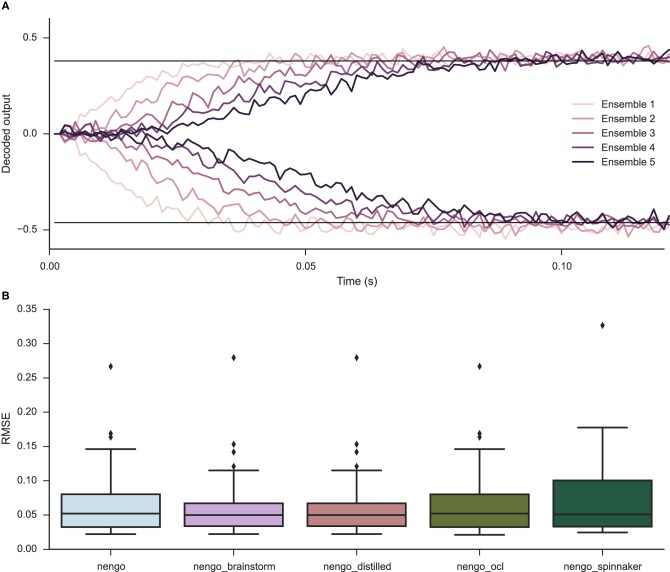
Chained communication channel model. (A) One example instance of the model run on the reference backend; the decoded output of the five chained two-dimensional ensembles during the first 12 ms of the simulation are shown. Each ensemble reaches approximately the correct value (indicated with the solid black line) but with slight delays depending on their position in the chain. (B) The aggregated accuracy results for 50 trials of each backend on the chained communication channel model. The observed metric is the root mean-squared error (RMSE) between the decoded output of the last ensemble in the chain and the correct value (which is randomly selected on each trial), during the last 100 ms of the 500 ms simulation. The box shows the median and interquartile range, while the whiskers extend to the farthest data point within 1.5 times the interquartile range; outliers are shown above and below the whiskers.